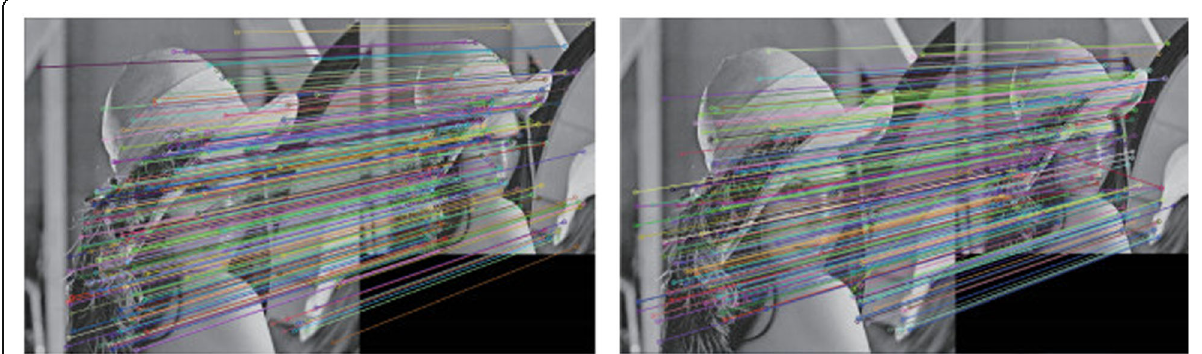
Fig. 4 Feature extraction of images using different